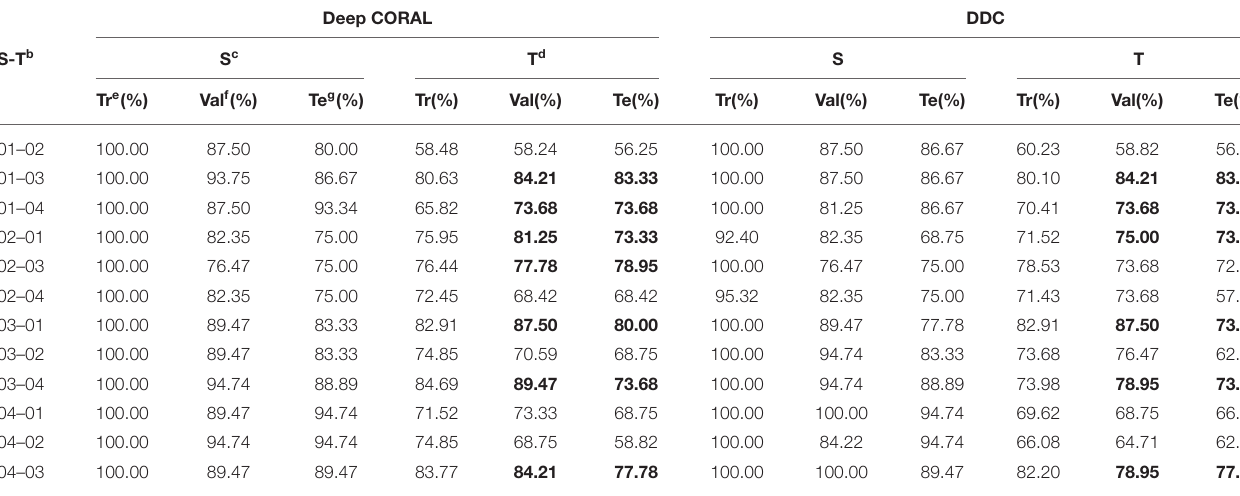
TABLE 5 | Classification results of Deep CORAL and DDC ( fc 5 a ).